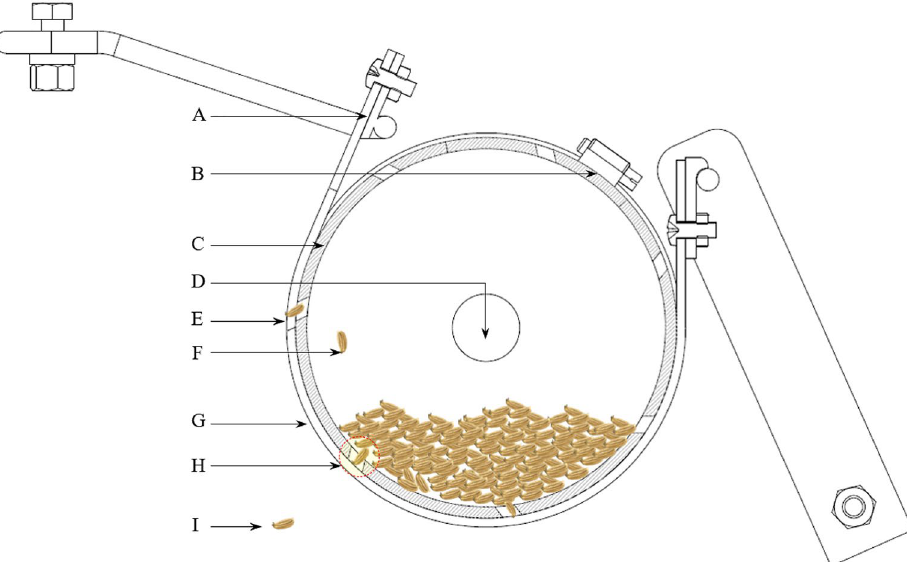
Figure 1. Schematic diagram of the metering assembly with features as ( A ) rigid frame that holds the strap and the cylinder through bolts; ( B ) lock mechanism of the cylinder; ( C ) metering cylinder; ( D ) shafting through which the metering cylinder rotates; ( E ) hole discharge point of the strap showing a seed about to fall into the ground; ( F ) excess seeds from the seed cell falls back into the cylinder; ( G ) strap; ( H ) seed cell inclined at 45°; and ( I ) discharged seed.